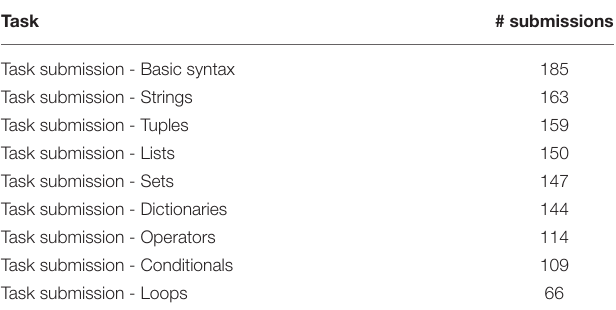
TABLE 6 | A number of attempts in the programming exercises.